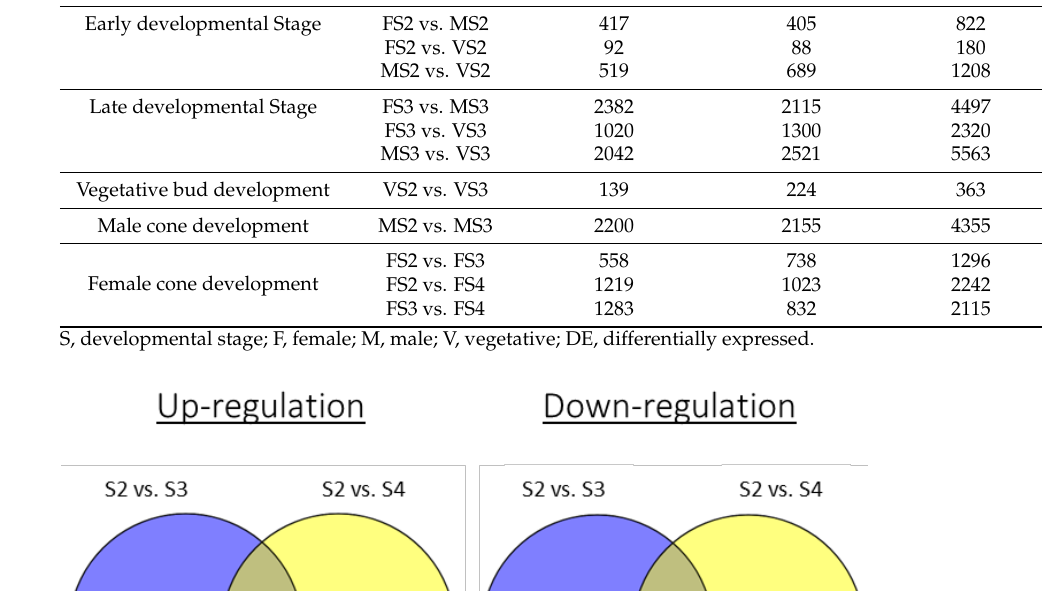
Table 2. Number of differentially expressed genes between the different bud types, and between the developmental stages in each bud type.